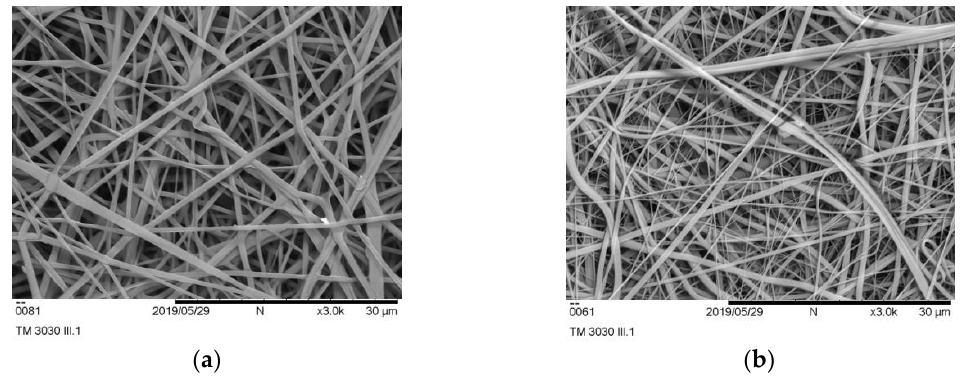
Figure 1. SEM micrographs of ( a ) PLA nanofibers, ( b ) poly(vinyl-pyrrolidone) (PVP) nanofibers.